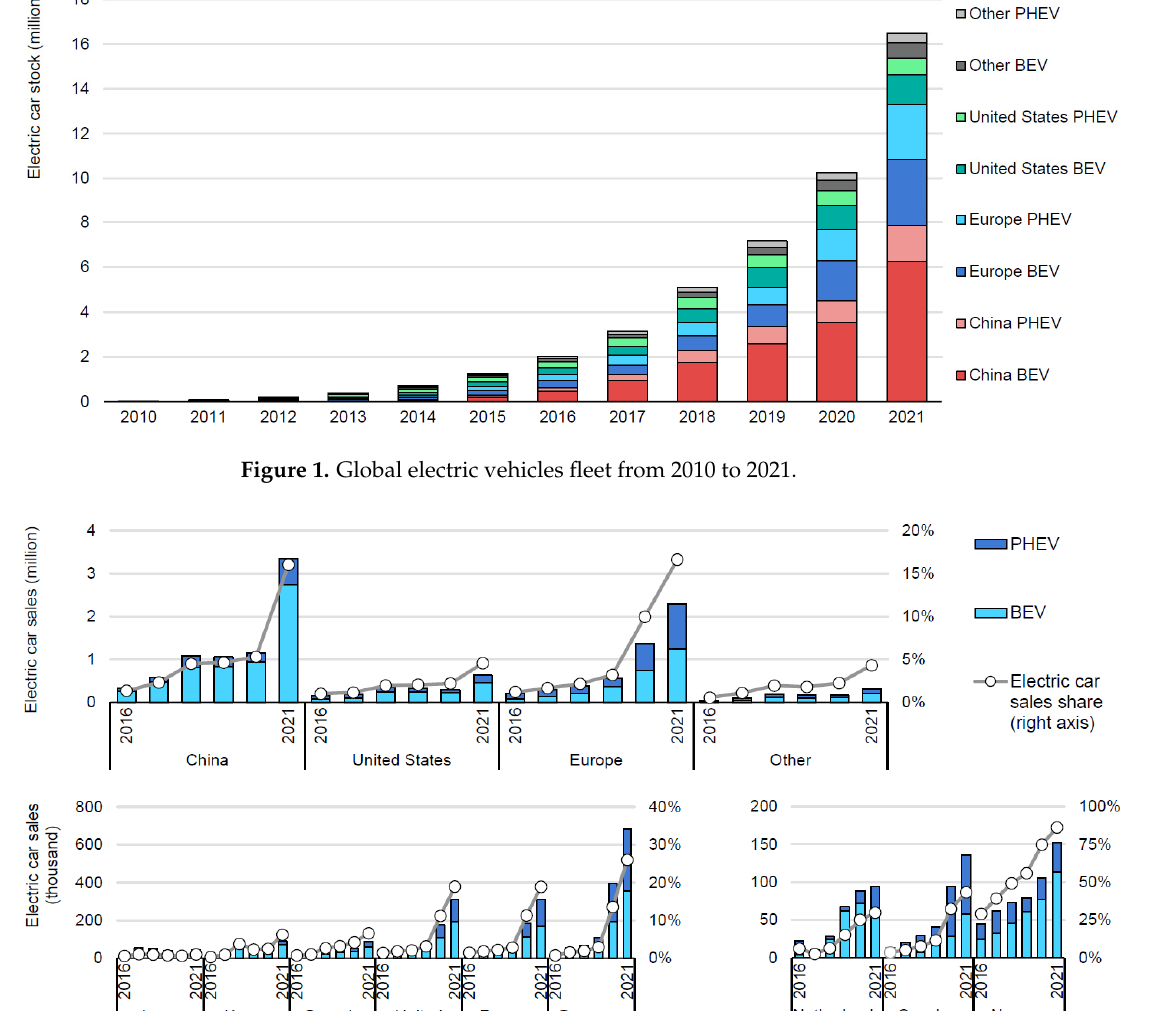
Figure 2. EV sales and market share worldwide from 2016 to 2021.